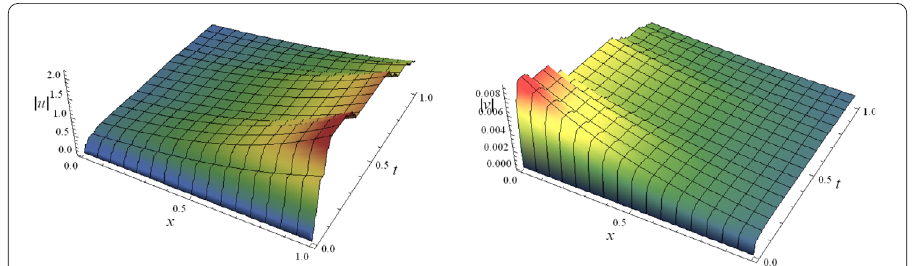
Figure 10 Space time structures of one-fractal solutions (206) and (207) with α = ln2/ln3.